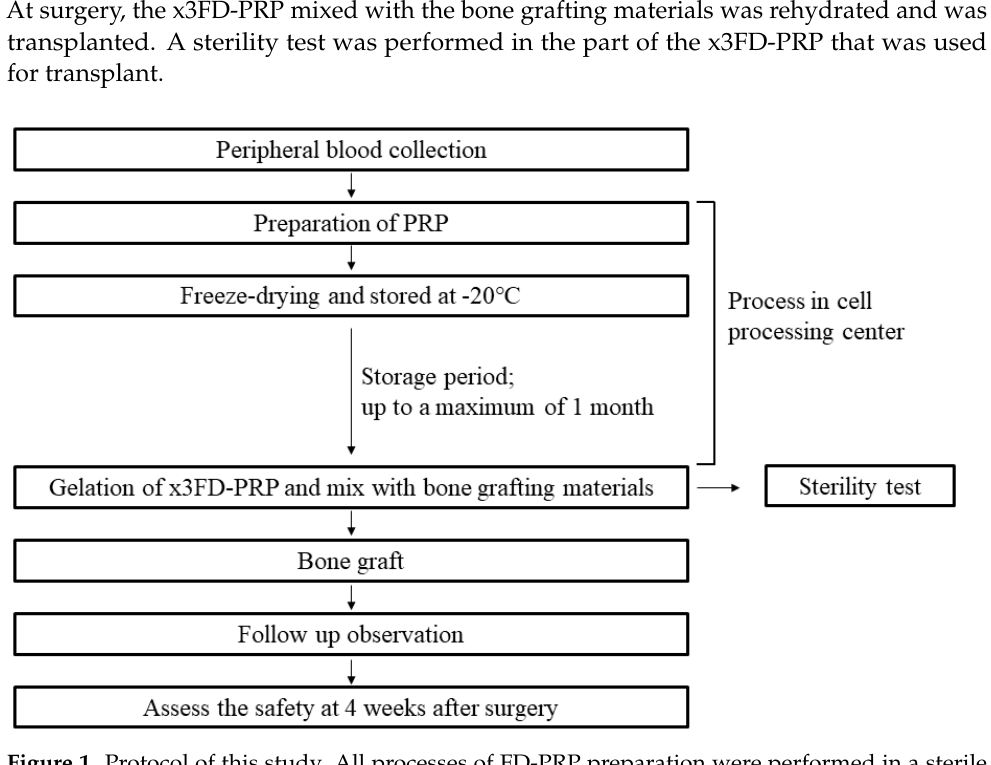
Figure 1. Protocol of this study. All processes of FD-PRP preparation were performed in a sterile room at the Nagasaki University hospital cell processing center, and the surgery was performed as a clean operation. A sterility test was performed in part of FD-PRP which was used for transplant. The safety verification was evaluated in terms of the clinical course until 4 weeks after surgery. The primary outcome of this clinical pilot study was a safety verification of x3FD-PRP for alveolar bone regeneration. The safety verification was assessed using the clinical course and in consecutive laboratory examinations. The secondary outcome was a clini- cal evaluation focused on bone regeneration in sinus floor augmentation analyzed by a radiographic examination and an implant stability